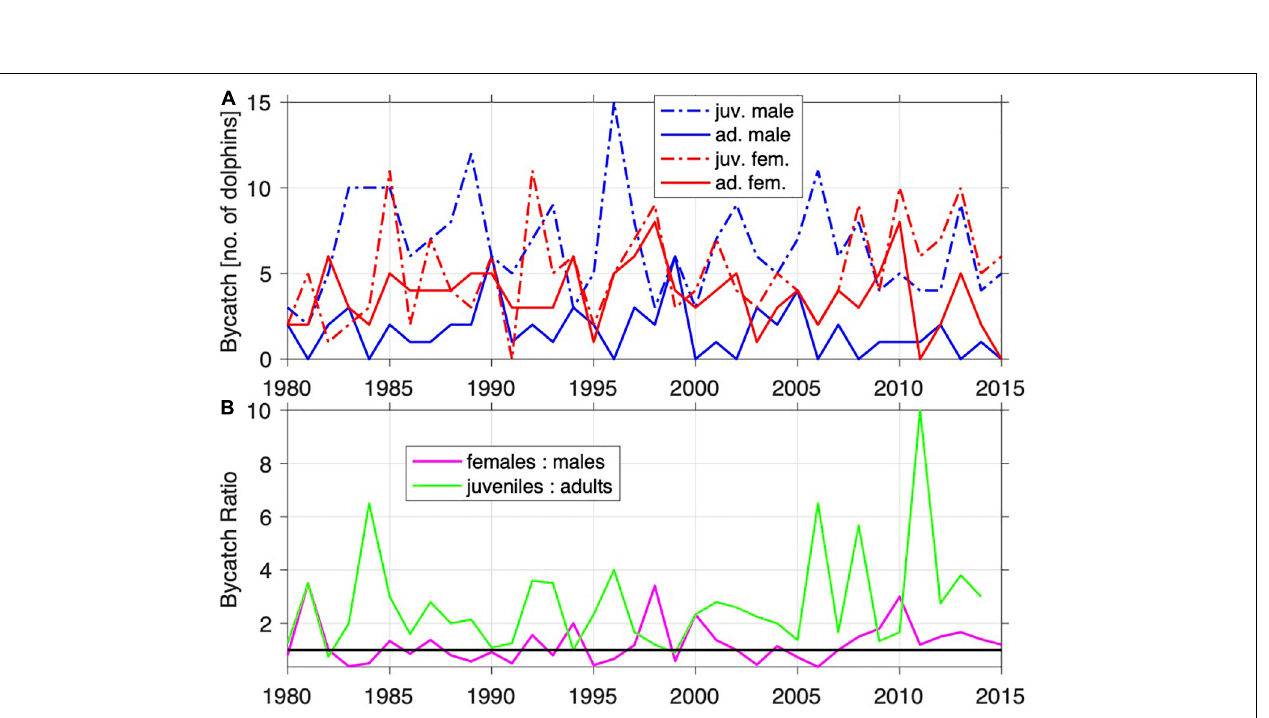
Frontiers in Marine Science |